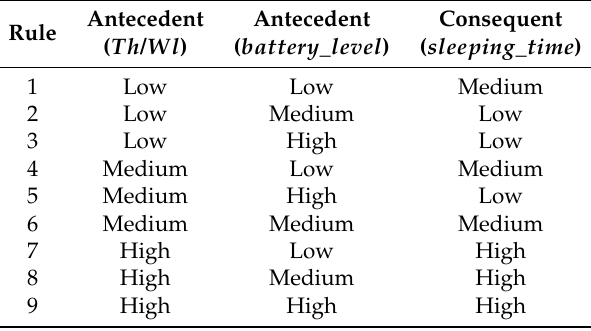
Table 2. Inference rules.